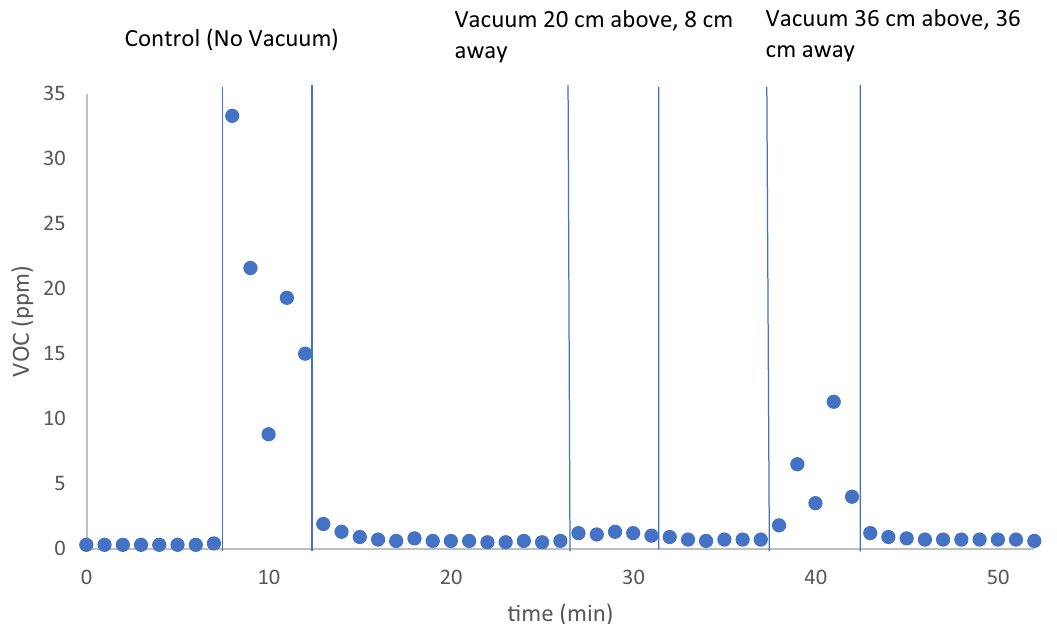
Figure 3. Detected VOC levels before during and after mixing are shown for the control (no vacuum) and for two positions of the vacuum nozzle, the first being 20 cm above and 8 cm away from the bowl, and the second being 36 cm above and away from the bowl. A fresh batch of bone cement was mixed for each condition. The vertical lines indicate the start and end of mixing.